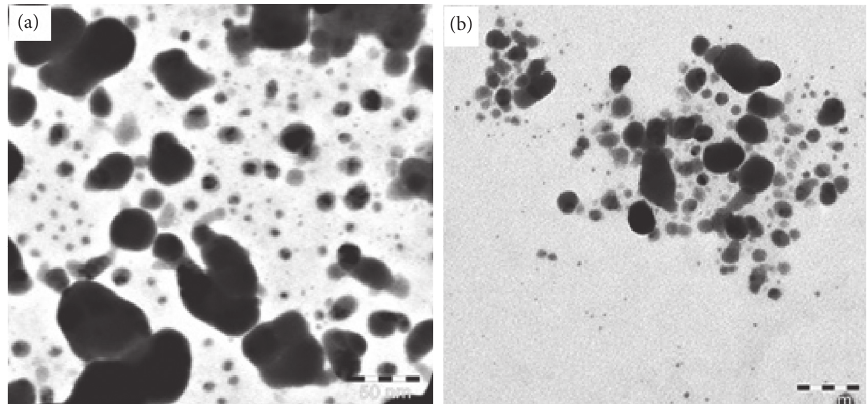
Figure 5: (a) High-resolution transmission electron microscopy micrographs of prepared AgNPs from Ch-TQ; (b) high-resolution transmission electron microscopy micrographs of prepared AgNPs from Ch-TAMPy. Table 1: Antimicrobial activity of Ch-TQ and Ch-TAMPy nanoparticles against the tested pathogenic microbes.